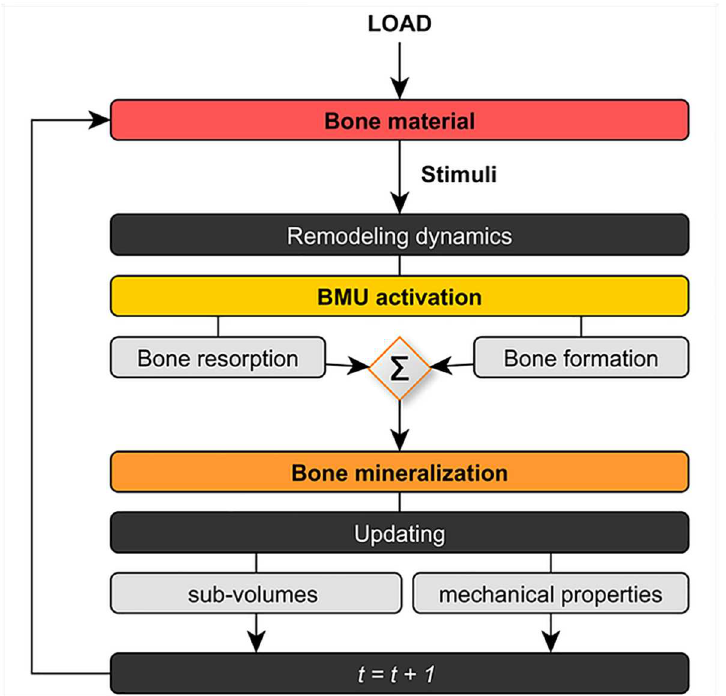
Fig 2. Simplified schemeof the bone-remodelling computational model [21]. Note that, for simplicity, some additionalfeatures like biological factors and damagedynamicsare not shown in this flowchart to avoid confusion.Nonetheless, they are still present in the current